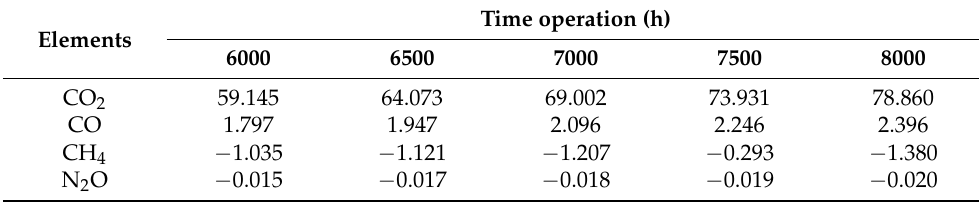
Table 12. Emission avoidance between open-field burning and rice straw-fired power plants.